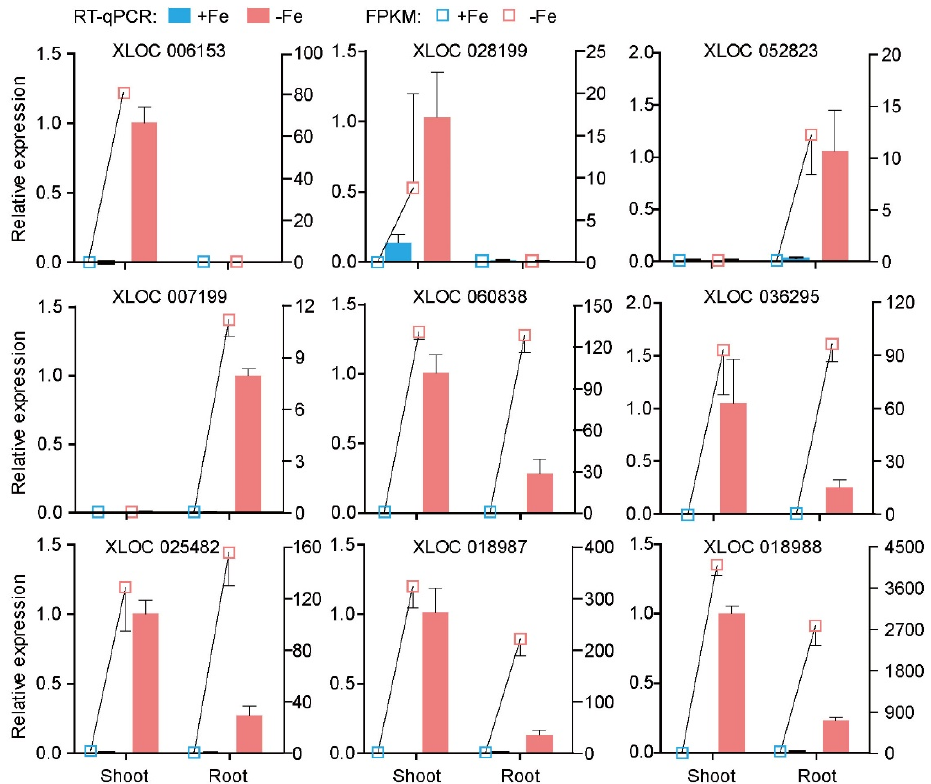
Figure 4. RT-qPCR validation of nine lncRNAs responding to Fe deficiency in RNA-seq transcriptome. Nine lncRNAs were chosen to perform RT-qPCR analysis. The relative expression level of the lncRNAs was presented on the left axis, the right showed FPKM value from RNA-seq transcriptome. Actin was used as a reference gene, means ± SD were determined from three biological repeats.